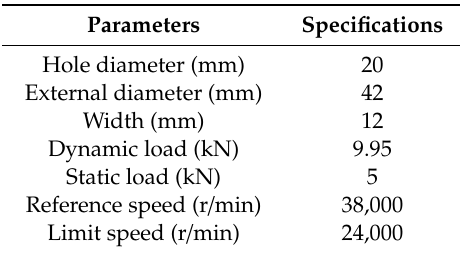
Table 1. SKF Explorer 6004 Bearing specifications.